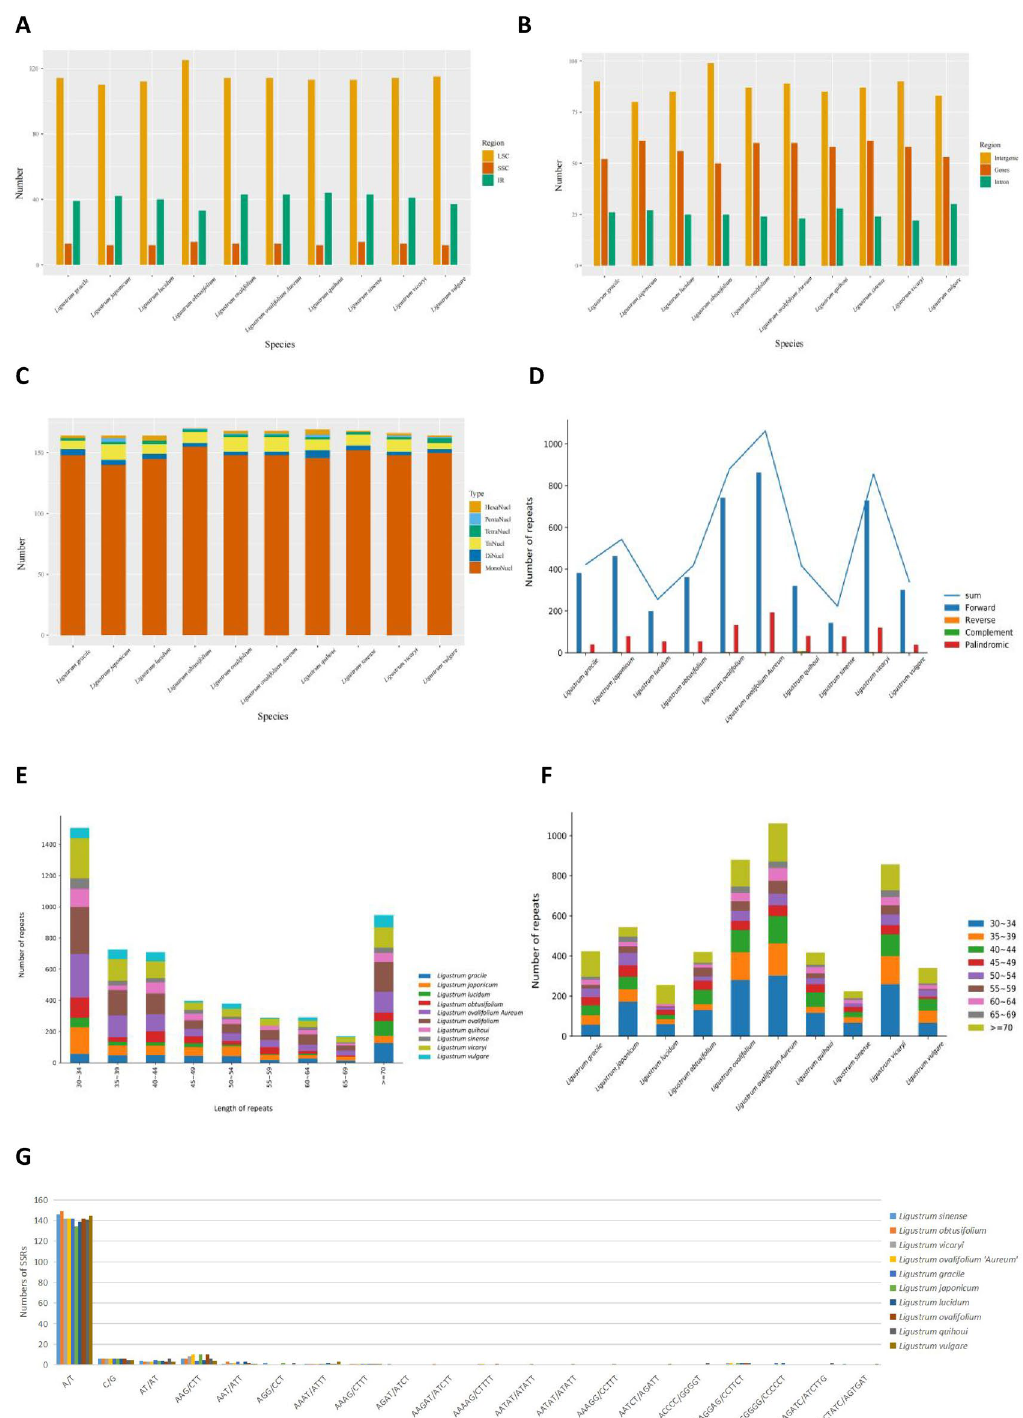
Figure 5. ( A ) Frequency of SSRs in the LSC, IR, SSC region; ( B ) Frequency of SSRs in the intergenic regions, protein-coding genes, and introns; ( C ) Type of SSRs; ( D ) Number of Forward repeat, Reverse repeat, Complement repeat, Palindromic repeat; ( E ) Length distribution of long repeats; ( F ) Length repeat species; ( G ) Analysis of simple-sequence repeats (SSRs) in the chloroplast genomes of ten Ligustrum